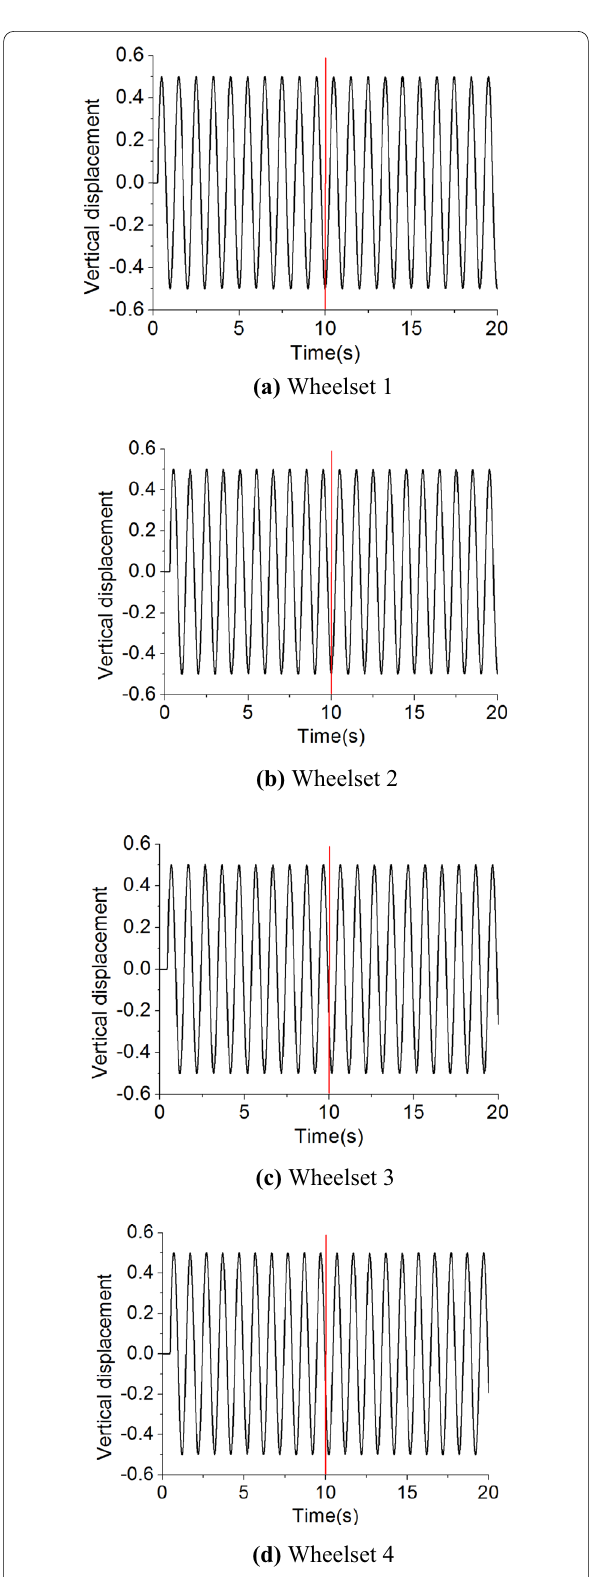
Figure 9 Vertical displacement of wheelsets